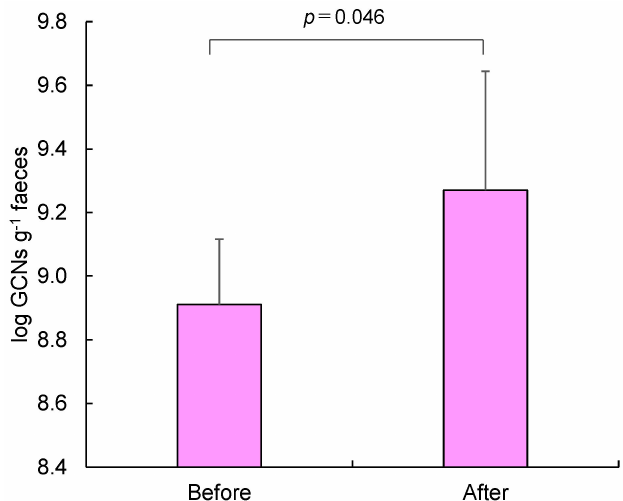
Figure 3. Comparison of the 16S rRNA gene copy numbers of bifidobacteria in faeces of 6 healthy participants before (Day 2) and after (Day 17) daily ingestion of lactulose for 2 weeks ( n =